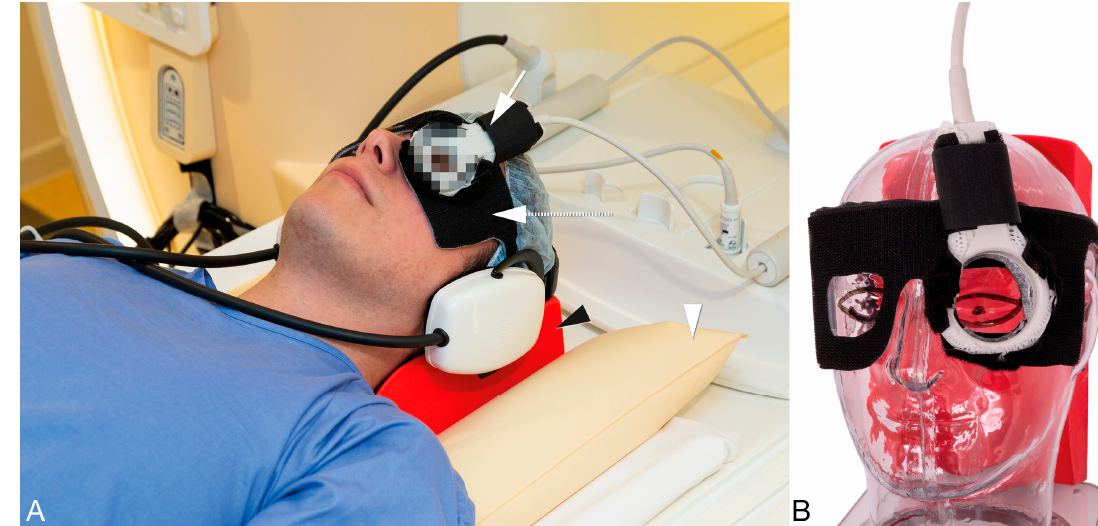
Figure 1. ( A , B ) Clinical setup for ocular MRI. ( A ) The patients’ head is supported by a radiotherapy head support (black arrowhead) which is stabilized by two sandbags (arrowhead). To aid an easy mounting of the eye coil (arrow) a pair of goggles (dashed arrow) is used on which the coil can be attached with Velcro. ( B ) Positioning of the eye coil and of the pair of goggles exemplified on a phantom to better show their relationship with respect to the eye.